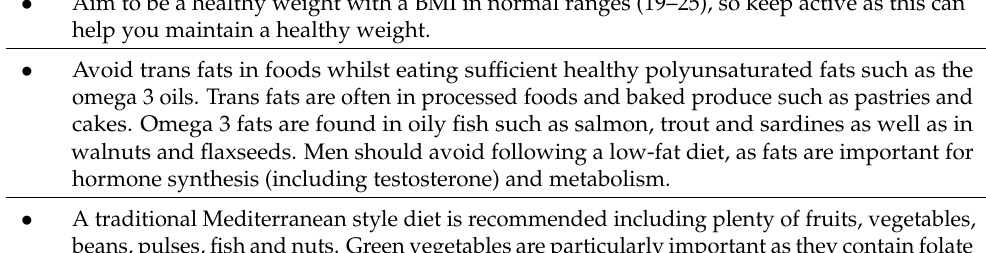
Table 2. Proposed Nutrition and Lifestyle Preconceptual Guidelines for